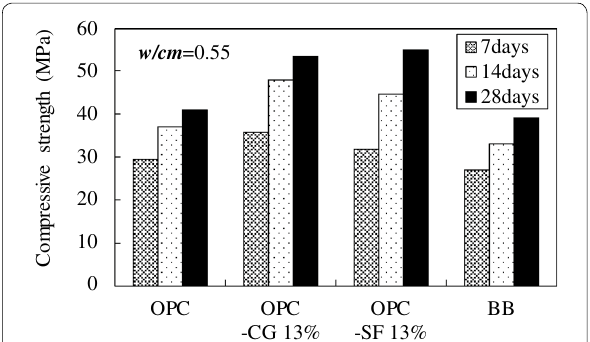
Fig. 2 Average compressive strength of each concrete composition.